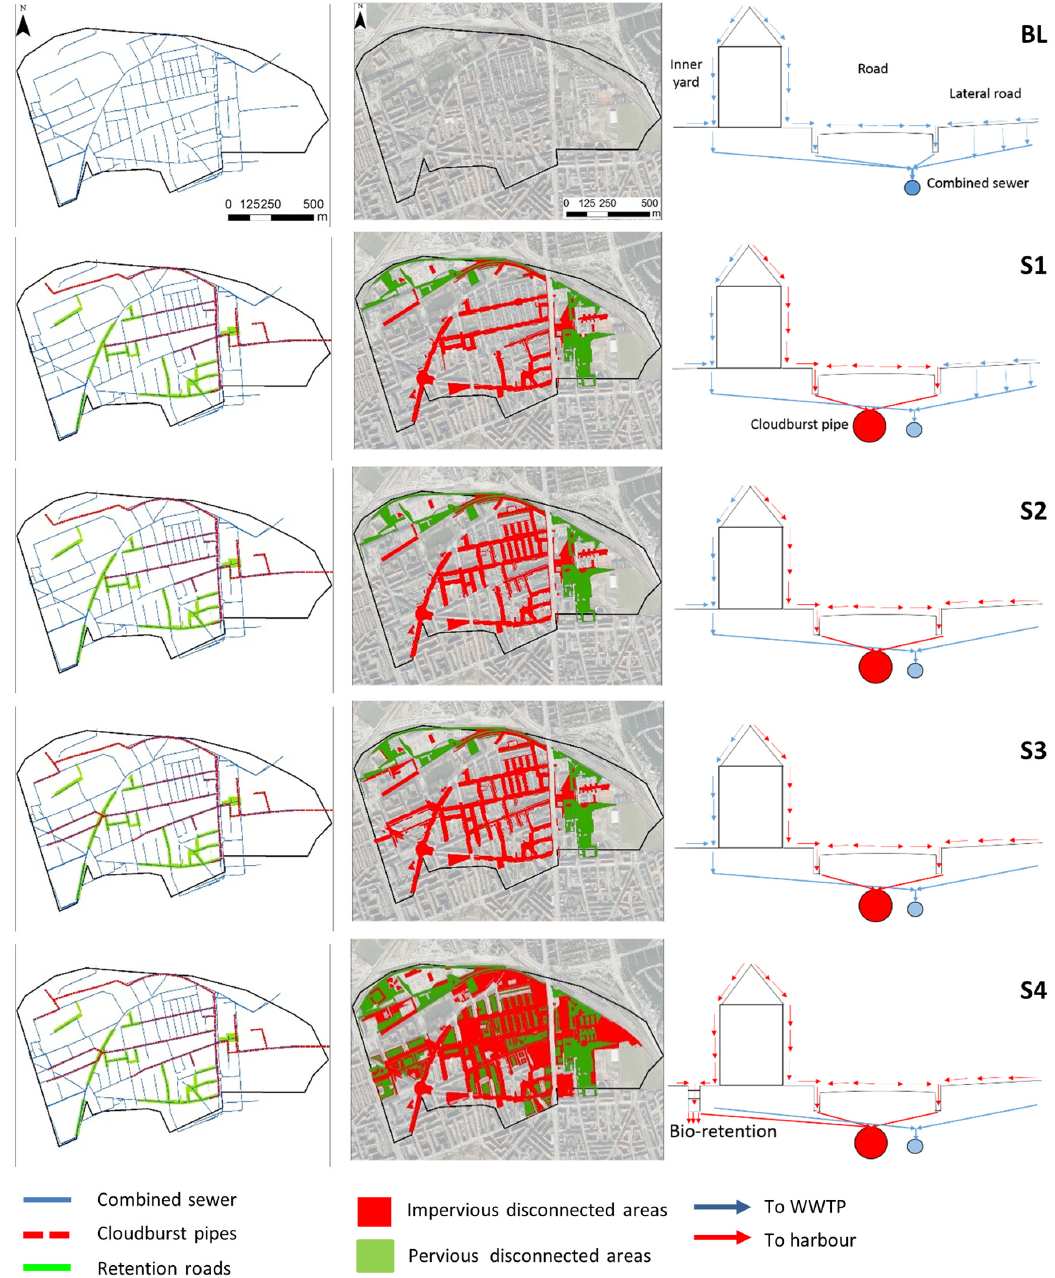
Figure 3. Overview of the different scenarios: ( left panel ) conveyance measures implemented in each scenario; ( centre panel ) areas disconnected from the combined sewer system in each scenario; ( right panel ) a typical street profile illustrating which surfaces are directed to the combined sewer system and to the cloudburst system, respectively.